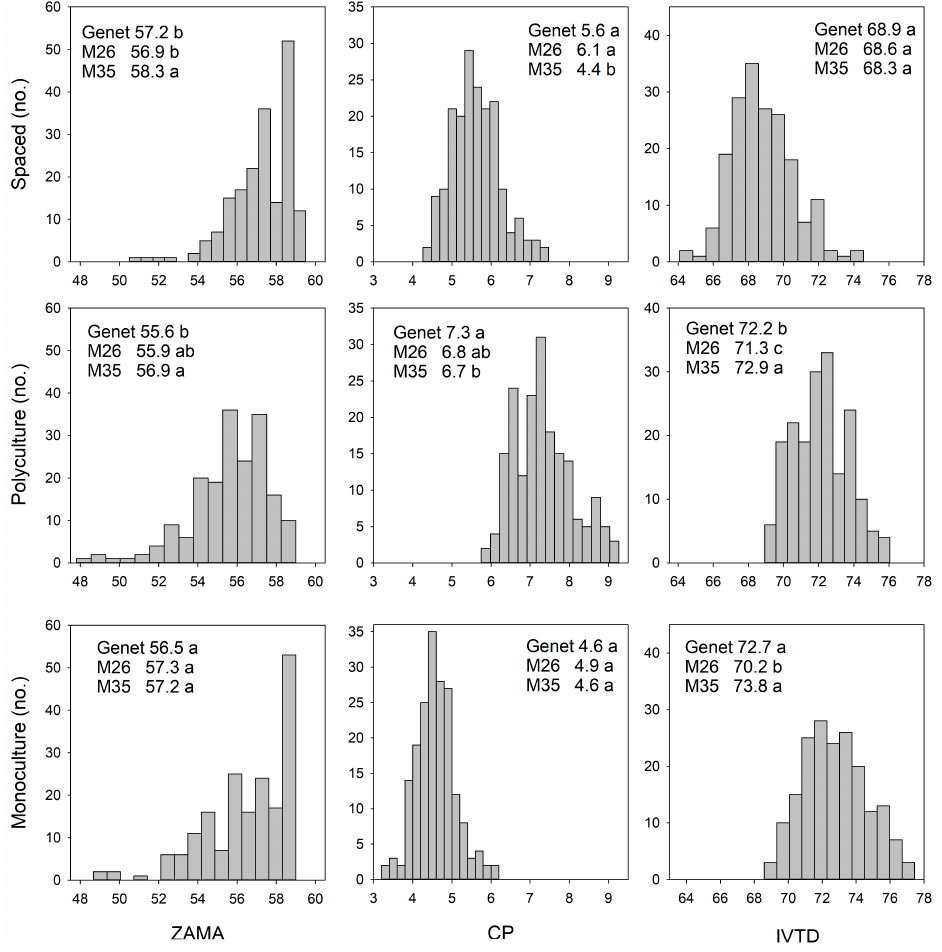
Figure 3. Range and frequency of maturity (ZAMA), crude protein (CP), and in-vitro digestibility (IVTD) for 192 full-sib progeny (genets) of the M26 × M35 intermediate wheatgrass mapping population evaluated over two years (2016–2017) at Logan, UT, USA in three clonally replicated competition environments (spaced-plants, grass − alfalfa polyculture, and grass monoculture). The genet and parent mean values followed by a different letter (a, b, c) are significantly different than each other at the 0.05 level of probability.